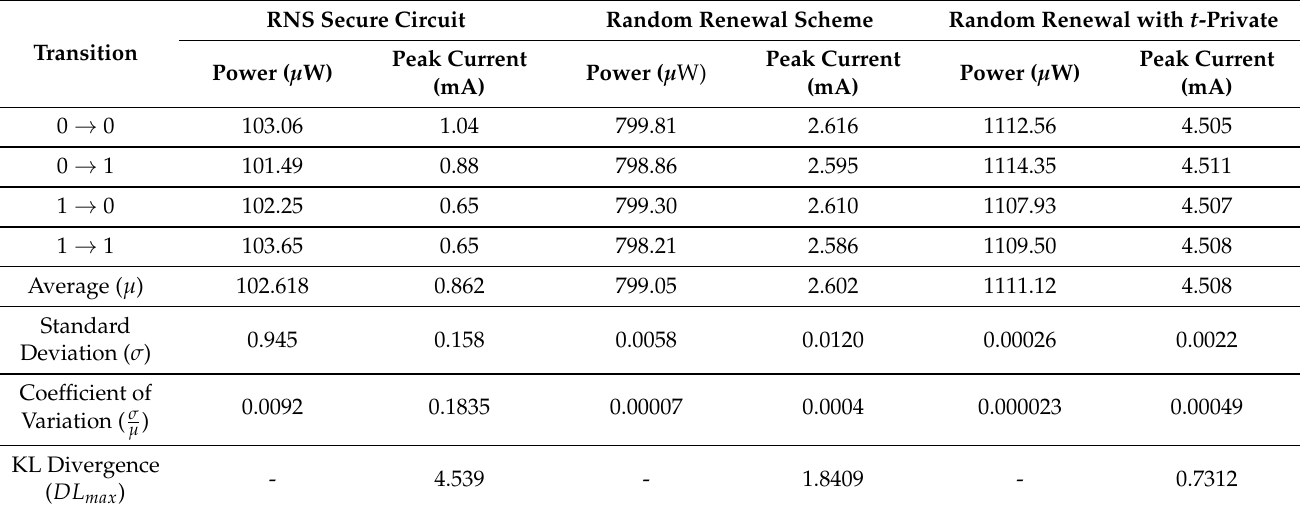
Table 3. SCA metrics for various RNS schemes with a single random